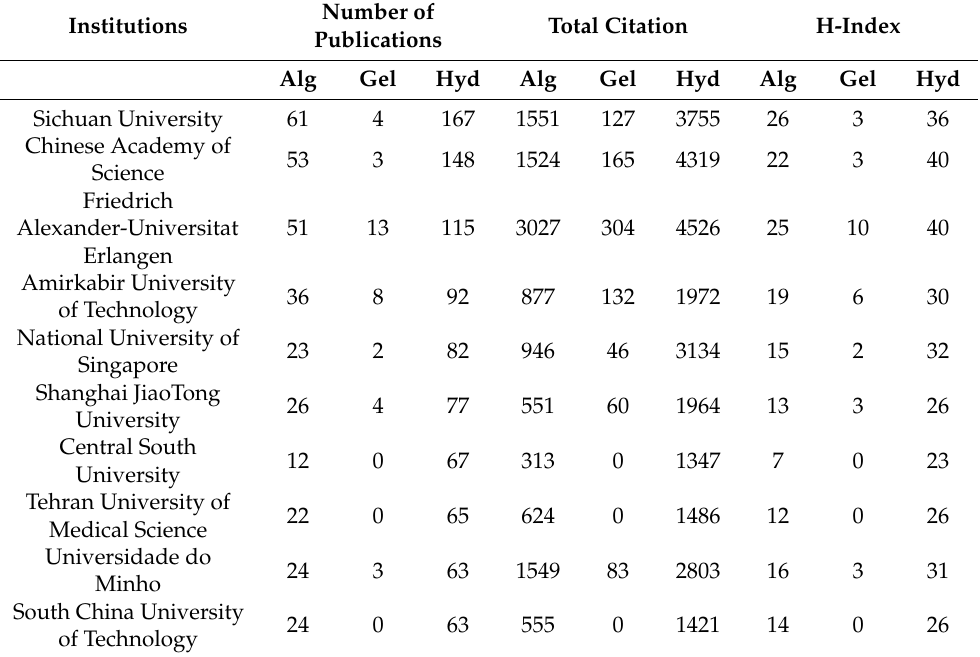
Table 7. Most productive